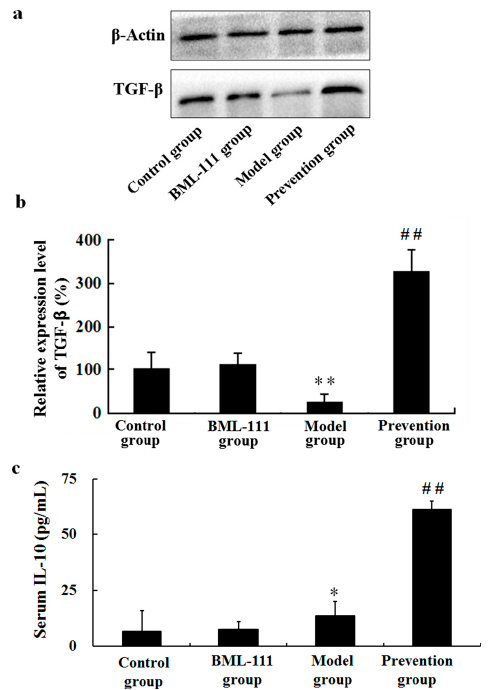
Figure 5. BML-111 increased the expression levels of TGF- β and IL-10. ( a ) Western blot analysis of TGF- β 1. The TGF- β 1 band (44 kDa) and the β -actin band (43 kDa) are indicated; ( b ) blots obtained